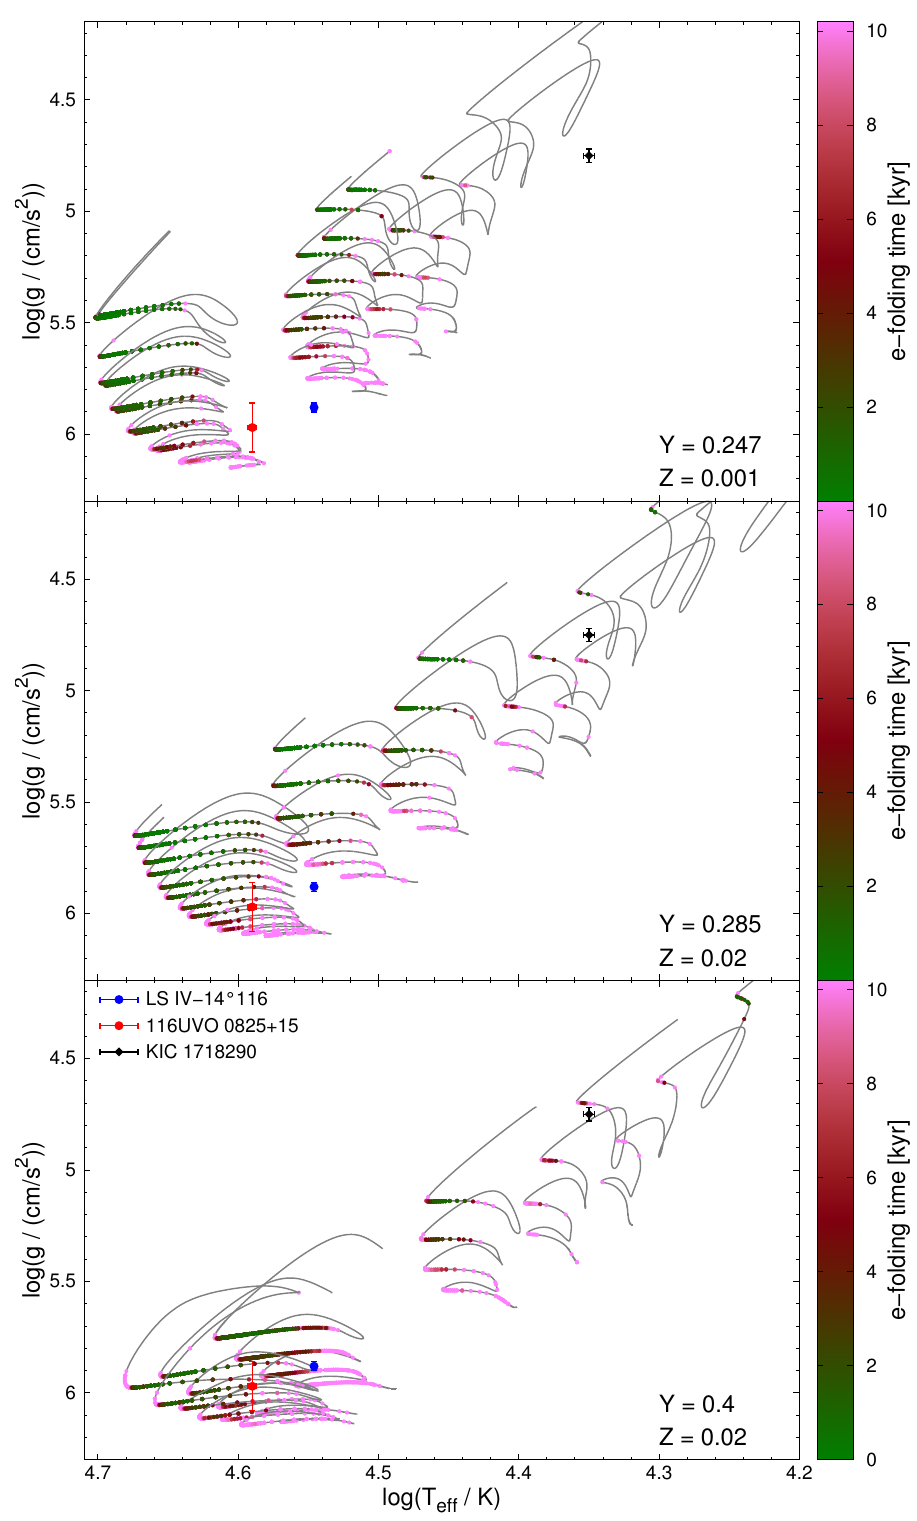
Figure 2. The phase of the He subflashes of the evolutionary sequences in the log T eff − log g diagram (grey lines). Coloured points corre- spond to models with excited modes and the colour coding shows the minimum e -folding time for each model. Also shown for comparison is the location of the known He-rich hot subdwarf pulsators LS IV-14 ∘ 116 (Randall et al. 2015), UVO 0825+15 (Jeffery et al. 2017), and KIC 1718290 (Østensen et al.